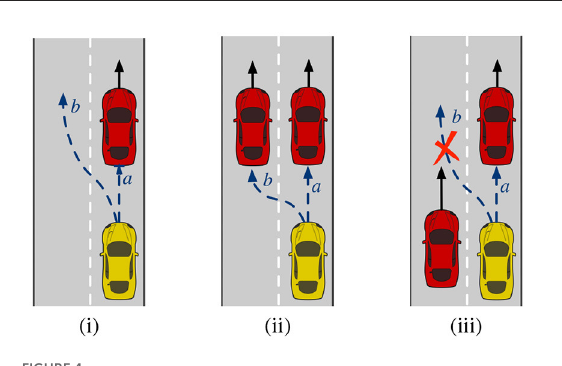
FIGURE4 Three simulated scenarios to test the collaboration between the agent and the human (yellow car) when other vehicles are present (red cars). The dashed arrows show the affordable actions. (i) It is possible to follow the red car or to overtake. (ii) It is possible to follow the car on the right or the one on the left. (iii) The only affordable action is to follow the car ahead.